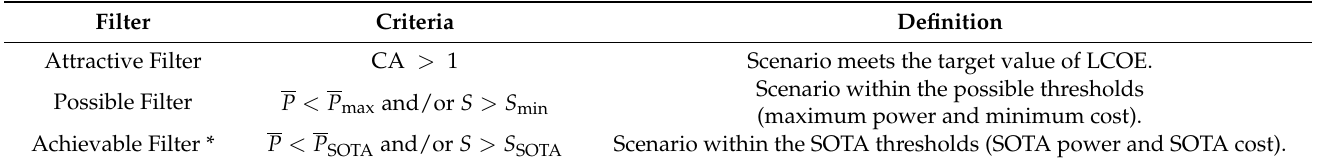
Table 8. The three filters used in the scenario creation tool and their definitions.